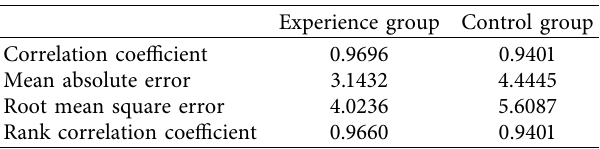
Table 3: Comparison of edge correction performance of fast fading distorted